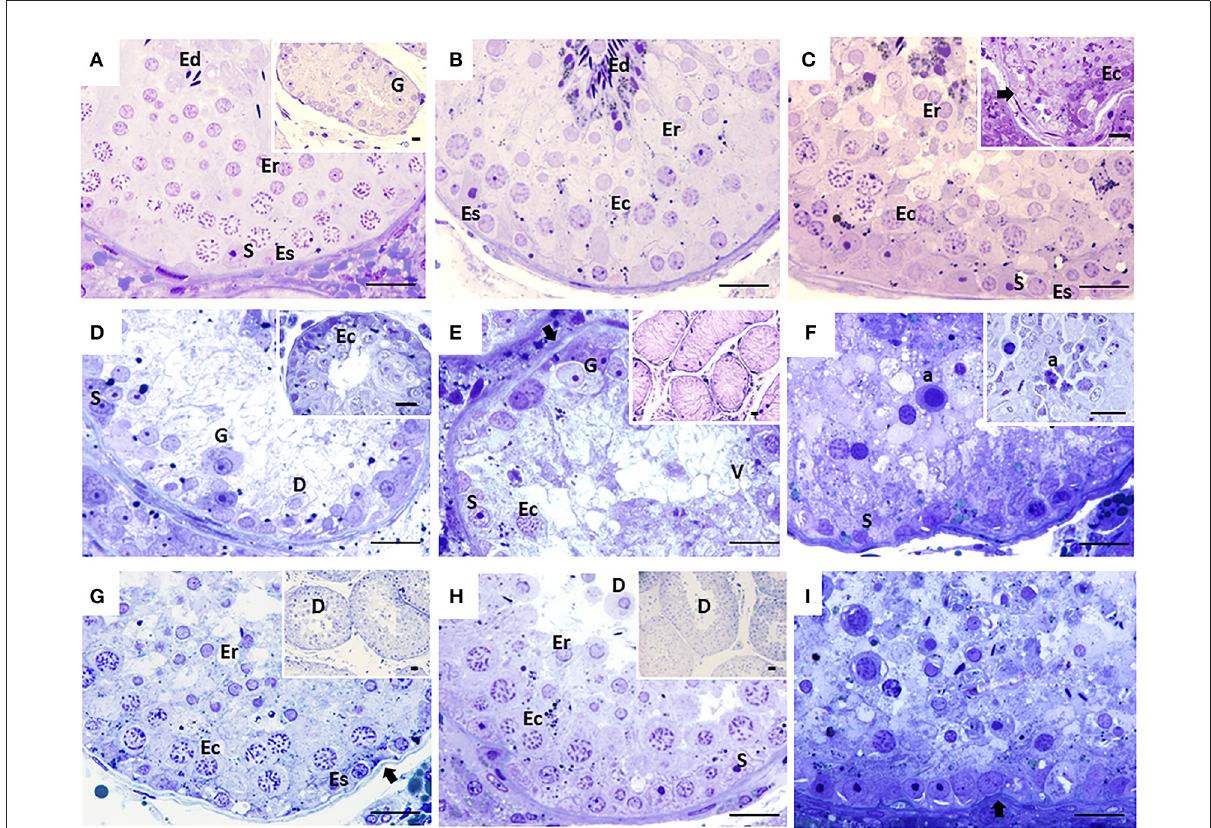
FIGURE1 Seminiferous tubules of dogs from the control (CTRL) (A–C) , cryptorchid (CO) (D–F) and contralateral (CONTRA) (G–I) groups at peripubertal (first column); young adult (second column) and senile (third column) stages. In CTRL dogs, complete spermatogenesis is observed, although gonocytes were still observed in the peripubertal stage (A) . In the senile stage (C) , some specimens showed histological alterations such as thickening and folding in the basement membrane (arrow) and even complete disorganization of the seminiferous epithelium ( C insert). In animals with CO in the peripubertal stage, different degrees of maturation of the epithelium are observed, from the presence of gonocytes to spermatocytes ( D insert). Histological alterations become evident from the young adult stage (E) , which continued until senile (F) with vacuolization (V), desquamation (D), folding of the basement membrane (arrow), presence of atypical cells (F) , cellular degeneration and arrest of spermatogenesis, as well as Sertoli-cell-only syndrome ( E insert). In the contralateral testes, the degree of histological damage was not as severe as in the cryptorchid ones, presenting alterations such as hypoplasia and cellular degeneration, thickening and folding of the basement membrane (arrow) with cellular desquamation (D). The CONTRA group images inserts show a panoramic view of the tubes. Gonocyte